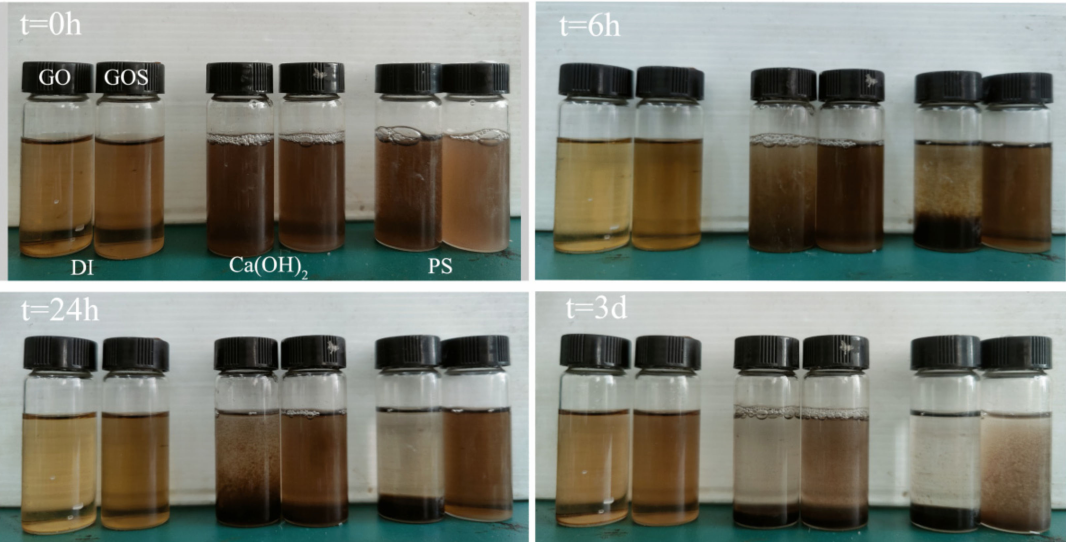
Figure 5. Visual observation of GO and GOS dispersion in different solutions when GO/GOS was added (t = 0 h, 6 h, 24 h, and 3 d).